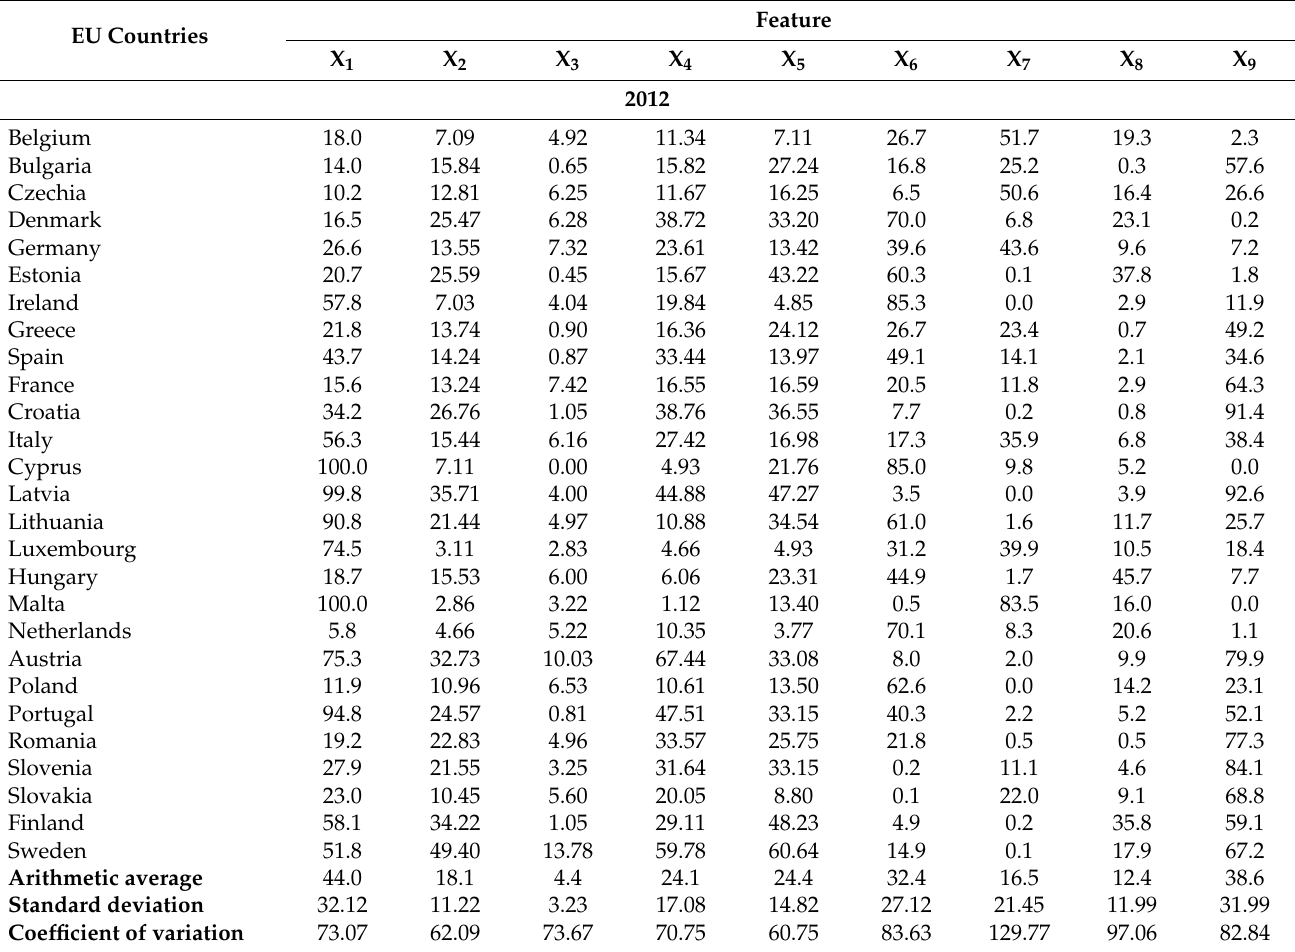
Table 1. Selected diagnostic features concerning the RES development level of EU countries in the years 2012 and